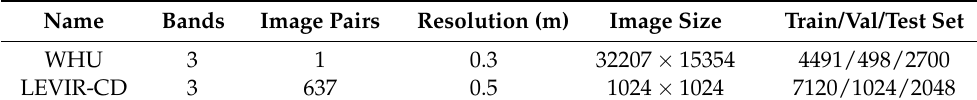
Table 1. A brief introduction to the two datasets.